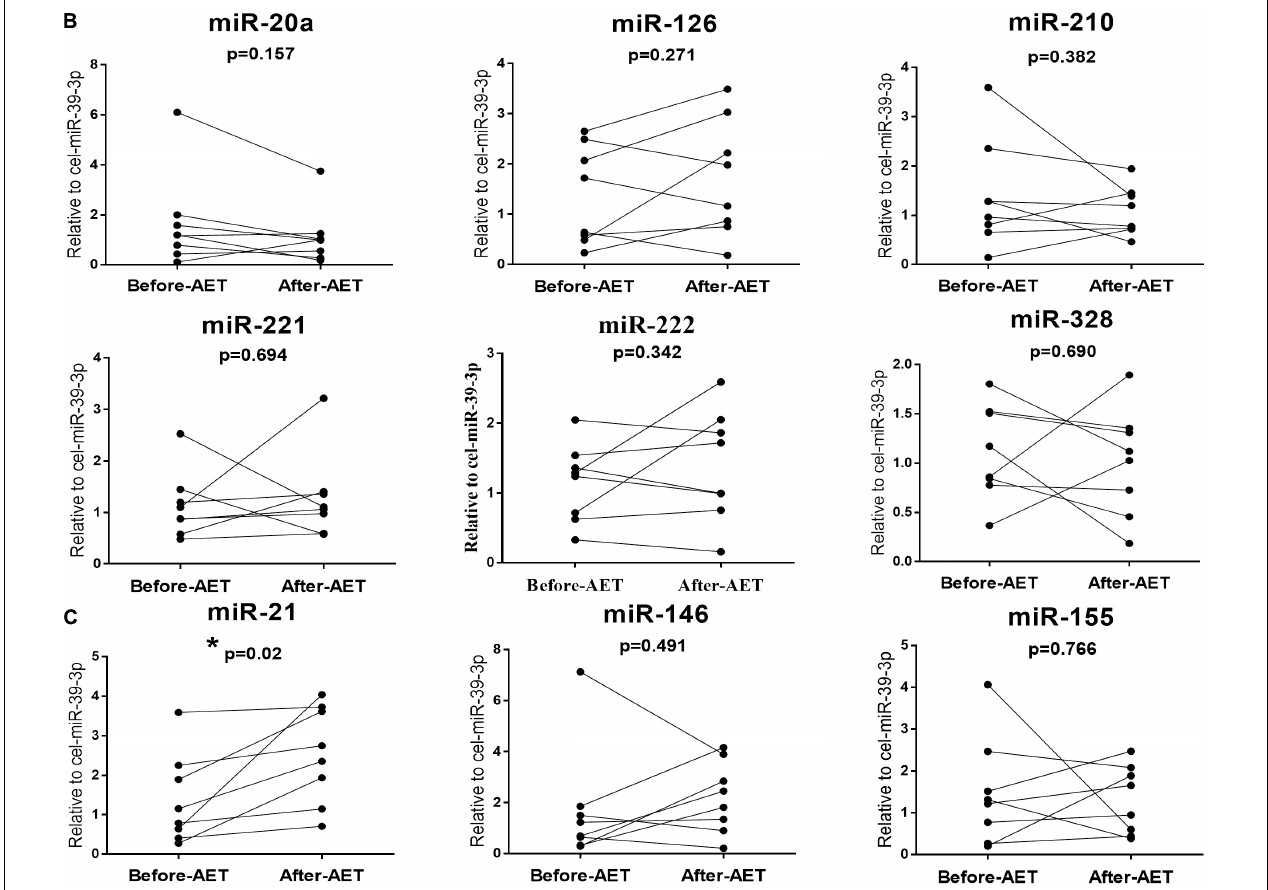
FIGURE 2 | Distinct regulatory profiles of selected circulating miRNAs before and after AET. (A) Serum levels of cardiac or muscle-specific/enriched miRNAs before and after AET. (B) Serum levels of angiogenesis-related miRNAs before and after AET. (C) Serum levels of inflammation-related miRNAs before and after AET. * P < 0.05; n =